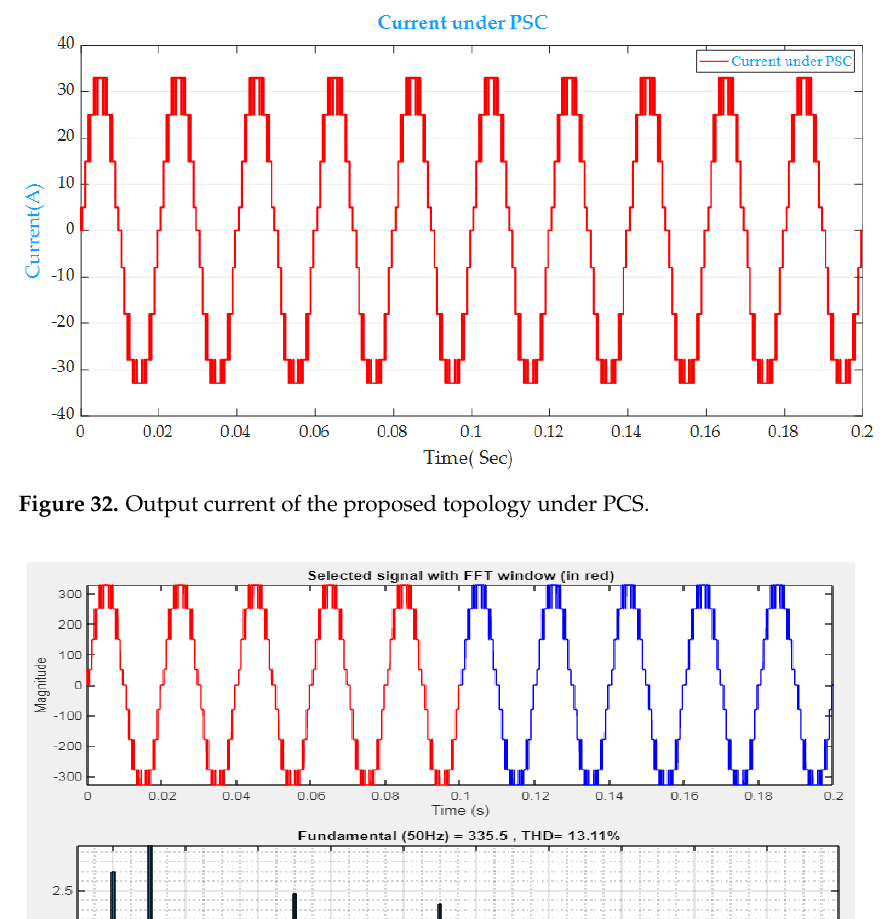
Figure 31. Output voltage of the proposed topology under PCS.